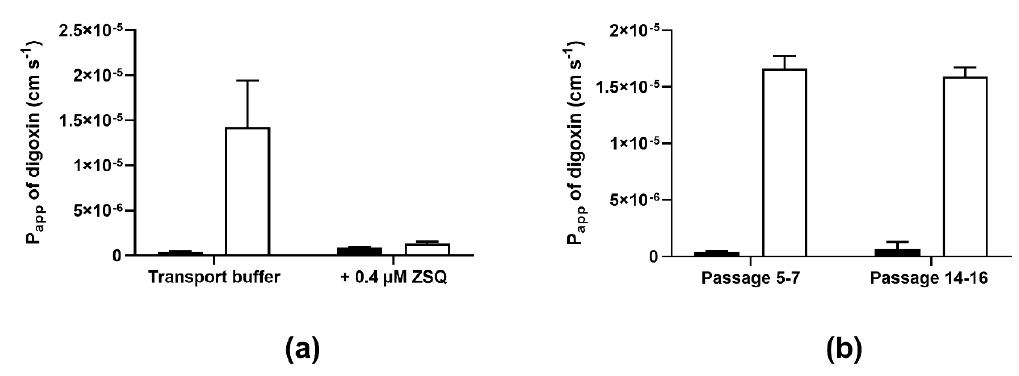
Figure 2. Bidirectional transport of digoxin across IPEC-J2 rat Mdr1a monolayers. ( a ) Bidirectional transport of digoxin across cell monolayers was measured in the presence or absence of the P-gp inhibitor, zosuquidar (ZSQ, 0.4 μ M). ( b ) Bidirectional transport of digoxin across IPEC-J2 Mdr1a cells collected from early (5–7) and late (14–16) passages. Apparent permeability (P app ) values were calculated from the steady-state fluxes, as described in the Methods Section. Filled bars show P A-B values and open bars show P B-A values. Values are given as means ± SEM of 3 individual passages with 3 individual permeable supports for each passage and transport direction ( n = 3, N total = 9).